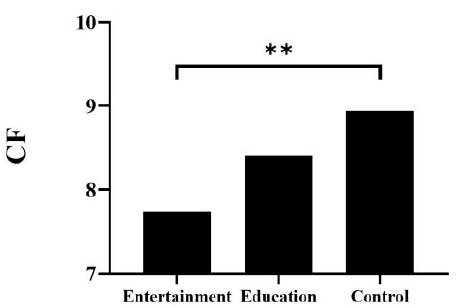
Figure 2. Comparison of CF in different groups. ** p < 0.01; CF: cognitive flexibility.